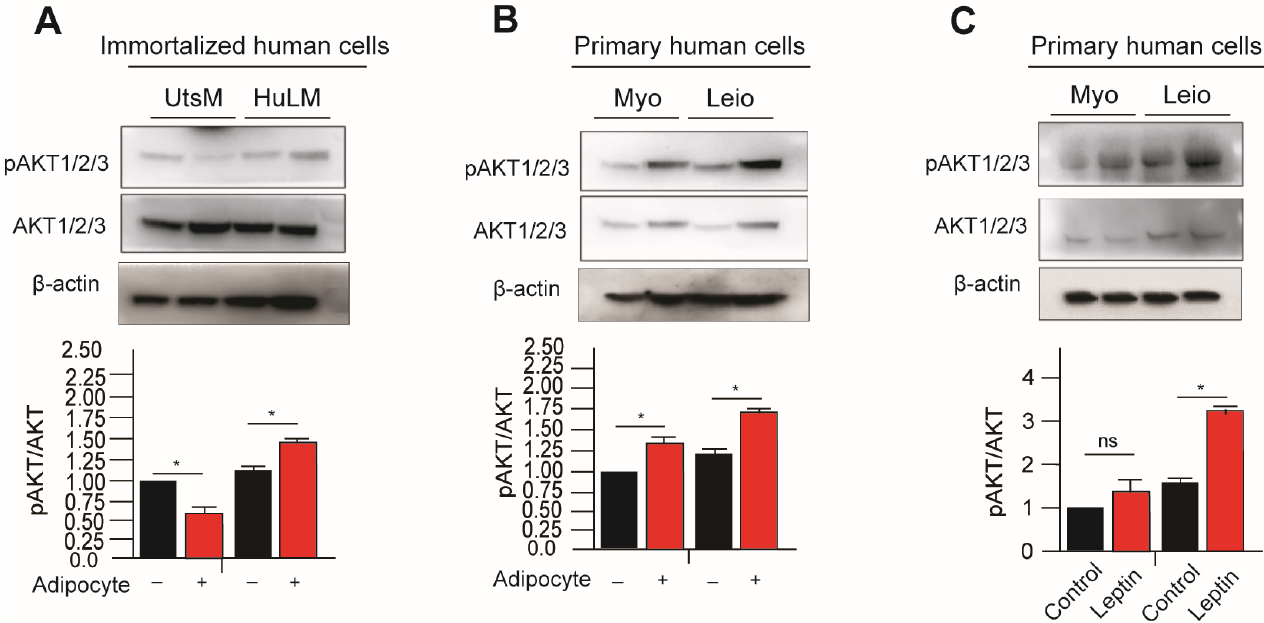
Figure 3. Leptin treatment and adipocyte coculture activates PI3K/AKT signaling in leiomyoma and myometrium cells. For eight days, the immortalized and primary human leiomyoma cells and my- ometrium and rat leiomyoma cells underwent adipocyte coculture. Every two days, 50% of the me- dium was exchanged with fresh medium. After eight days, cell lysates were derived from the cells cultured both with and without adipocytes. Western blotting was used to analyze phosphorylated AKT1/2/3/total AKT1/2/3 protein ratios using in ( A ) primary and ( B ) immortalized cells. Loading control was β -actin. Primary human leiomyoma and myometrium cells were treated with 100 ng/mL leptin for 48 h. Western blotting was used to analyze phosphorylated AKT1/2/3/total AKT1/2/3 pro- tein ratios ( C ). The loading control was β -actin. The mean ± SEM was determined from three inde-